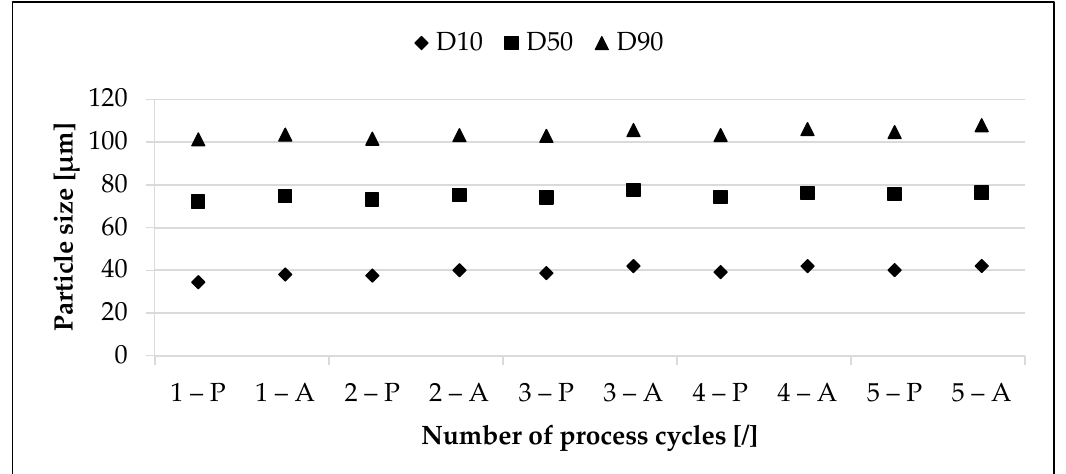
Figure 5. Influence of cyclic reuse on the characteristic values of the particle size distribution of the used polyamide 12 sinter material. Five process cycles were considered. The printing powder (P) and the aged powder (A) were analyzed respectively. The refresh rate was 30 wt%. Determined with Camsizer XT.